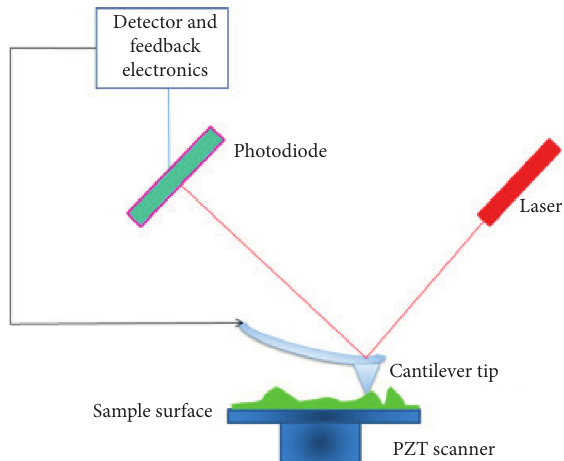
Figure 18: Illustration of the interaction between a sample and cantilever tip during AFM analysis [22].